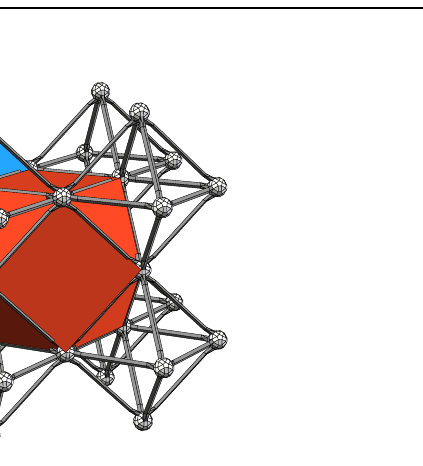
Fig. 2 | The gauge operators and stabilizers of the 3D STC. a The bulk (weight- three) X - and Z -type gaugeoperators, wherewedepictthe supportof operators as red and blue triangles, respectively. b The bulk (weight-12) X - and Z -type stabilizer operators, which can be formed in two different ways by multiplying gauge